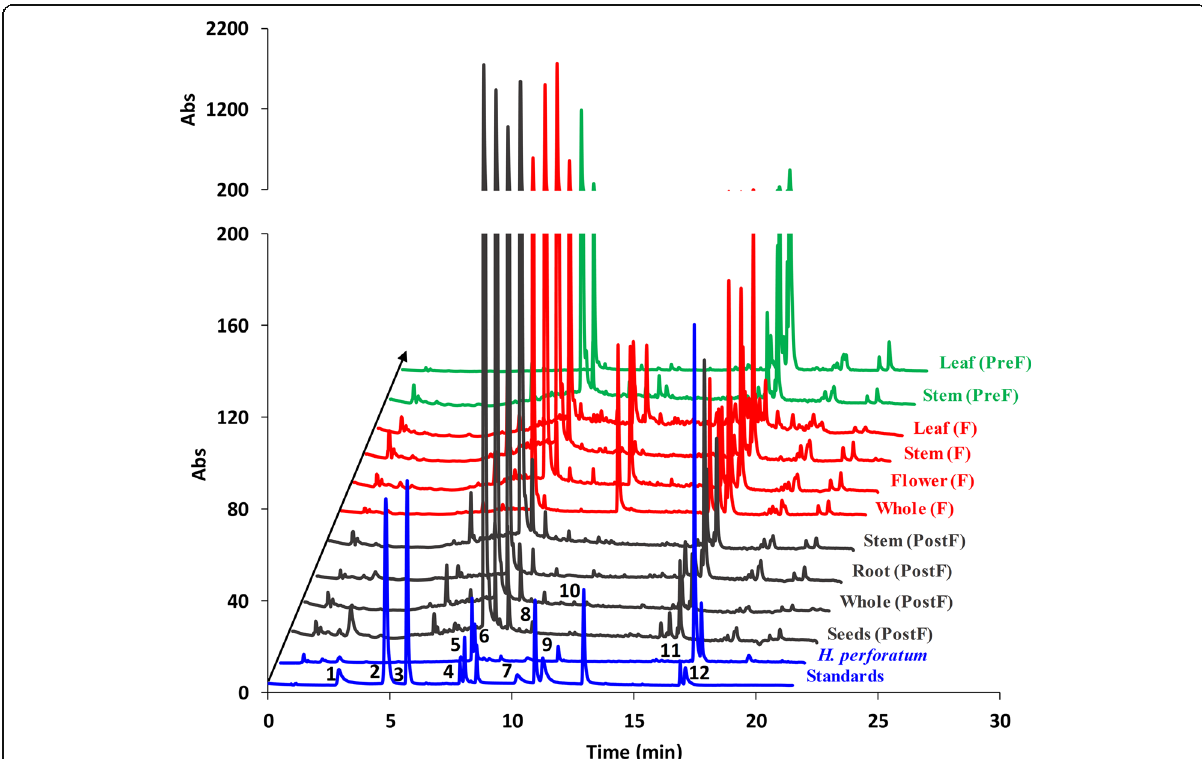
Fig. 2 HPLC profiles of the studied H. capitatum extracts. Standards: 1 – chlorogenic acid, 2 – p-coumaric acid, 3 – caffeic acid, 4 – rutin, 5- isoquercitrin, 6 – quercitrin, 7 – quercetin, 8 – apigenin, 9 – kaempferol, 10 – chrysin, 11 – hyperforin, 11 – hypericin. By far, the highest chromatographic peak is rutin which accounts more than 70% peak area, in all cases. The y axis is rescaled and adapted for